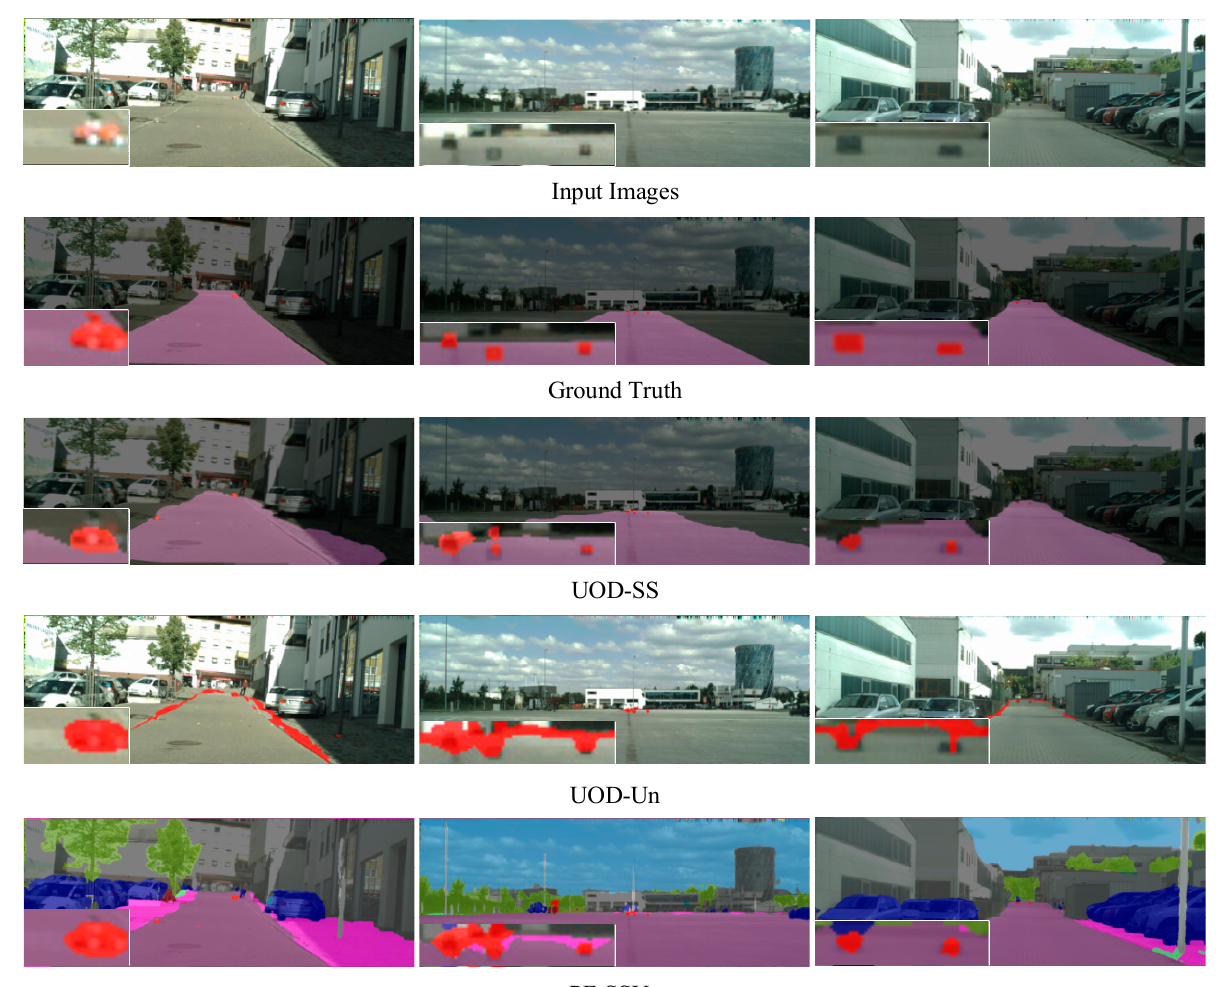
Figure 11. Display of test results.